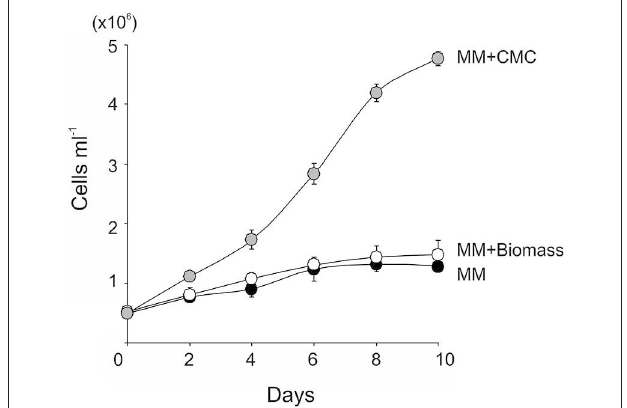
FIGURE 2 | Growth of the photosynthesis deficient strain (FUD16) of C. reinhardtii using wheat biomass as a carbon source. The FUD16 strain was cultivated in the TAP, the MM containing 15g L − 1 of CMC (MM + CMC), and the MM containing 15g L − 1 of wheat biomass (MM + Biomass). Three independent cultures were analyzed for each condition. Average values and standard deviations are shown.